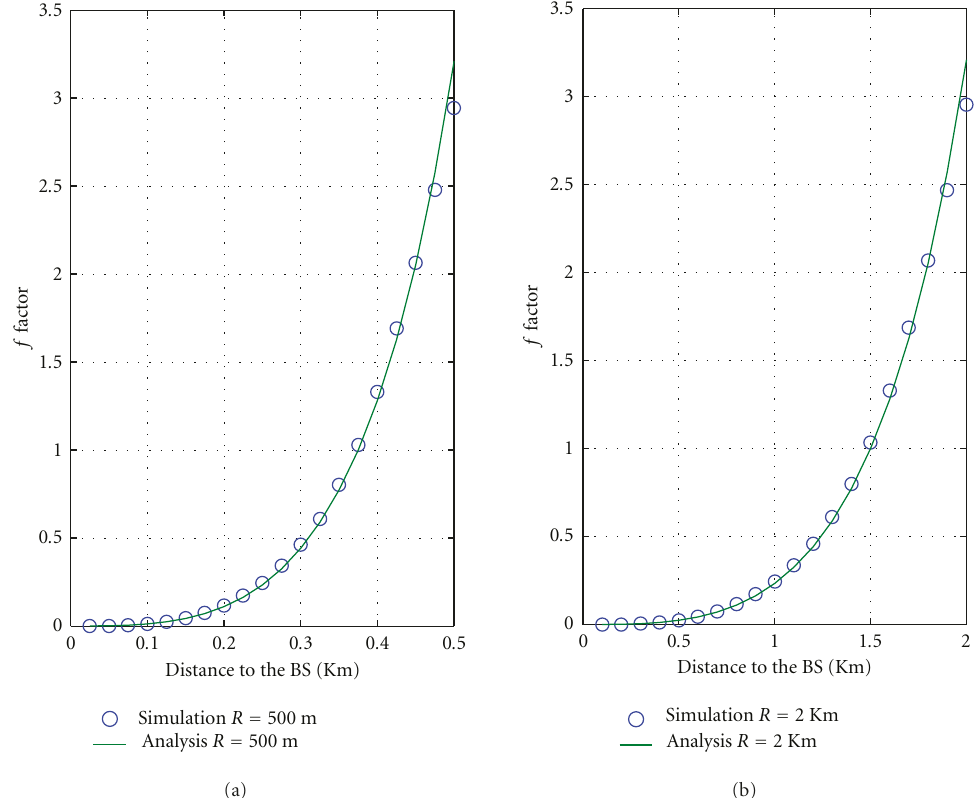
Figure 6: OCIF versus distance to the BS; comparison of the fluid model with simulations assuming cell radii R = 500 m and R = 2Km ( η =